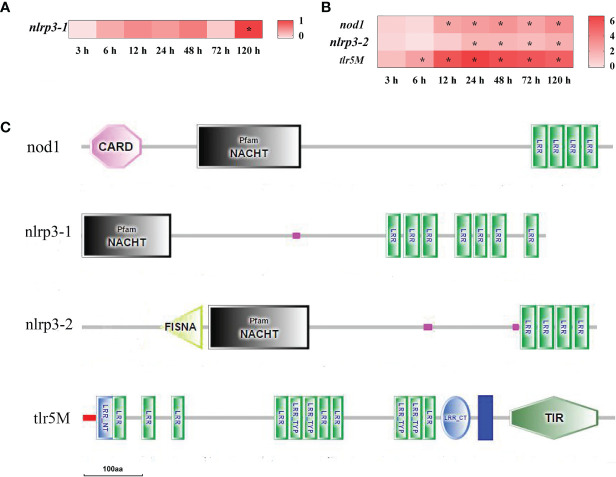
The DEGs of pattern-recognition receptor in yellow catfish after E. ictaluri infection. (A, B): The DEGs identified in the spleen and liver, respectively. The DEGs of pattern-recognition receptor were analyzed at 3 h, 6 h, 12 h, 24 h, 48 h, 72 h, and 120 h post-infection in the spleen and liver. The color gradient represents highly up-regulated (red) to highly down-regulated (white) genes. Significant differences at different time points post-infection compared to the control (0 h) are indicated by asterisks (*P < 0.05). (C): Structural features of pattern-recognition receptor DEGs in yellow catfish. The domain organizations were predicted by the SMART online server.